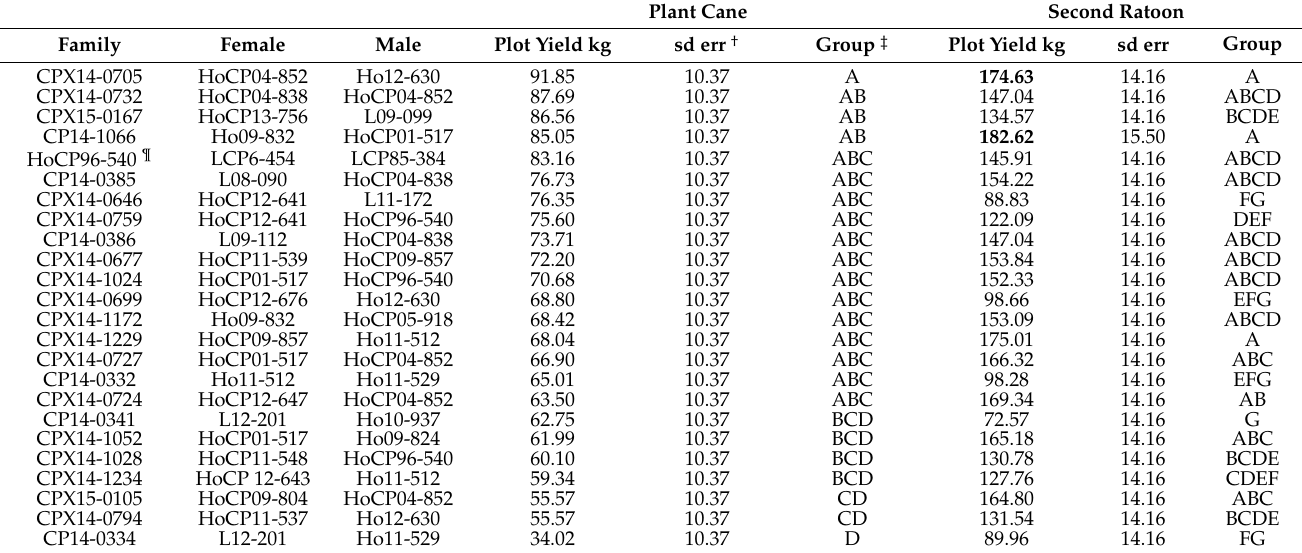
Table 1. Comparison of least square means of sugarcane seedlings cane plot weight. Plant Cane